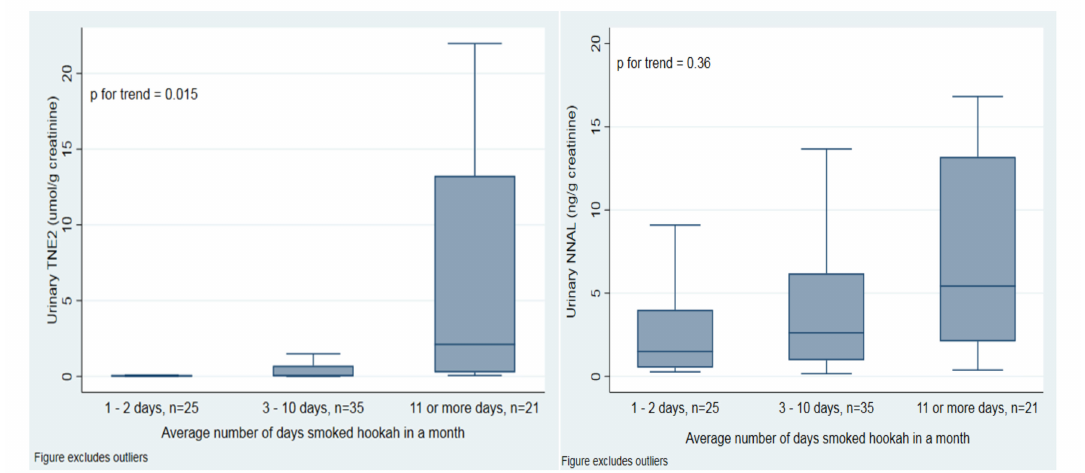
Figure 1. Weighted urinary TNE-2 and NNAL concentrations by average number of times smoked hookah in a month among past 30-day exclusive, established hookah users. Horizontal lines within boxes represent median values. The bottom and top of the boxes are the 25th and 75th percentiles. The distance between the top and bottom boxes represents the interquartile range (IQR). Top and bottom horizontal bars are the maximum and the minimum without outliers. Outliers have been excluded from the figures but remain in the